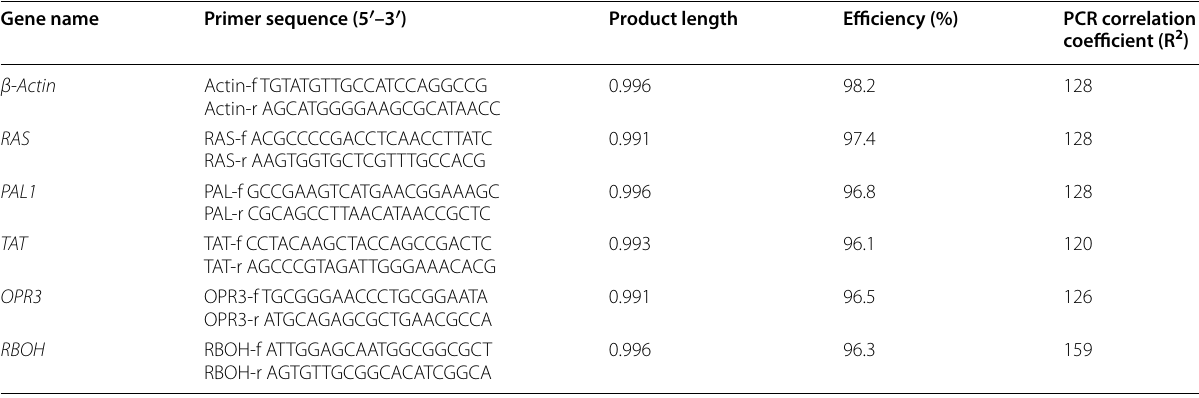
Table 1 Sequences of primers used in this study